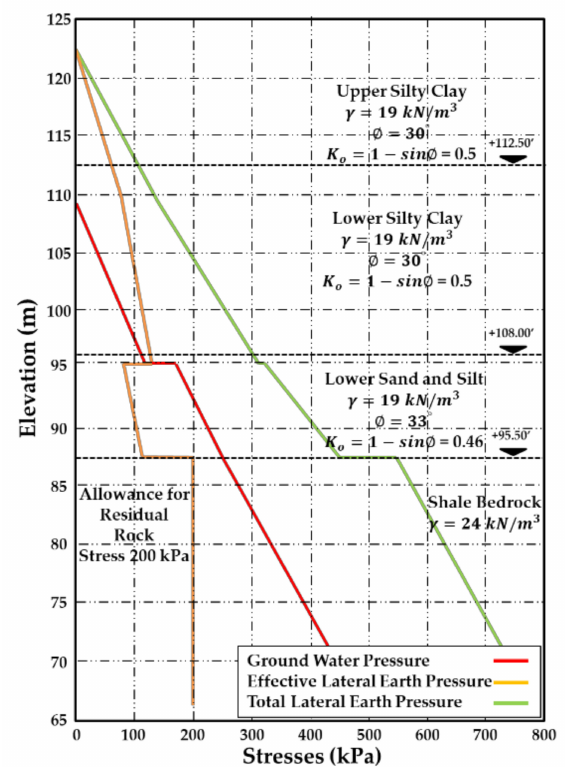
Figure 6. Shaft stress conditions with